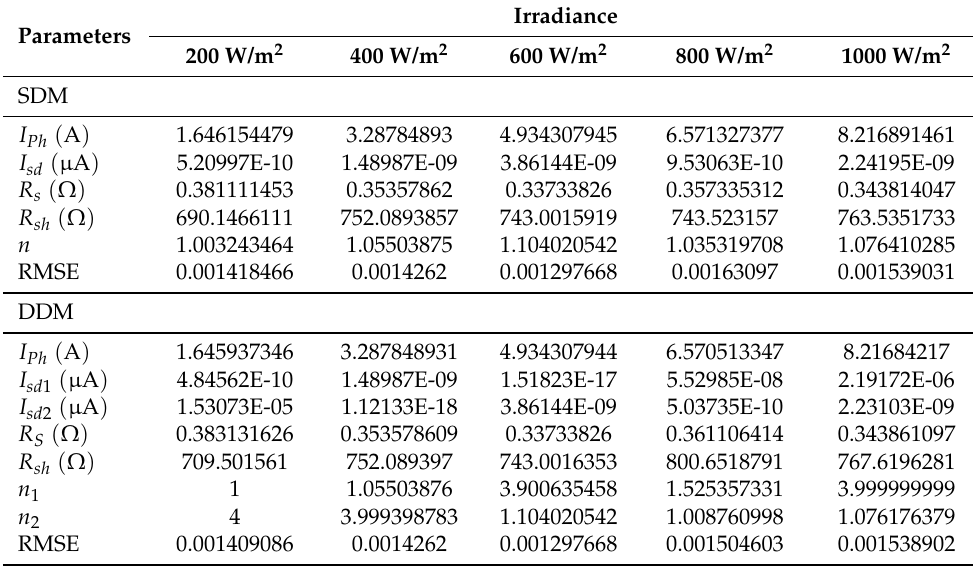
Table 14. Optimal parameters with various irradiance under 25 °C on KC200GT.